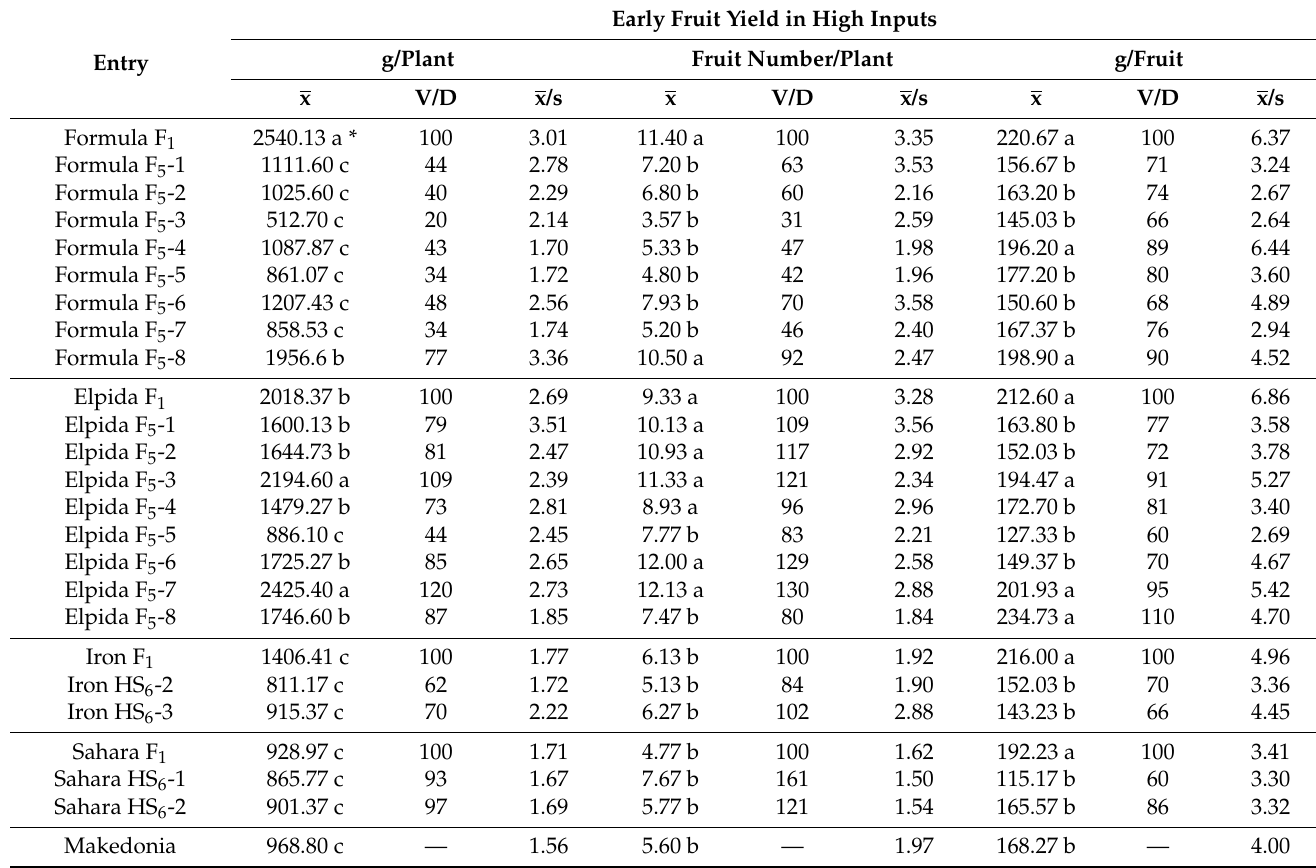
Table 1. Early fruit yield (g/plant, fruit number/plant, and g/fruit), vigor/depression (% of its corresponding hybrid), and stability of performance ( x /s) of the hybrids and recombinant inbred lines, in a high-input farming